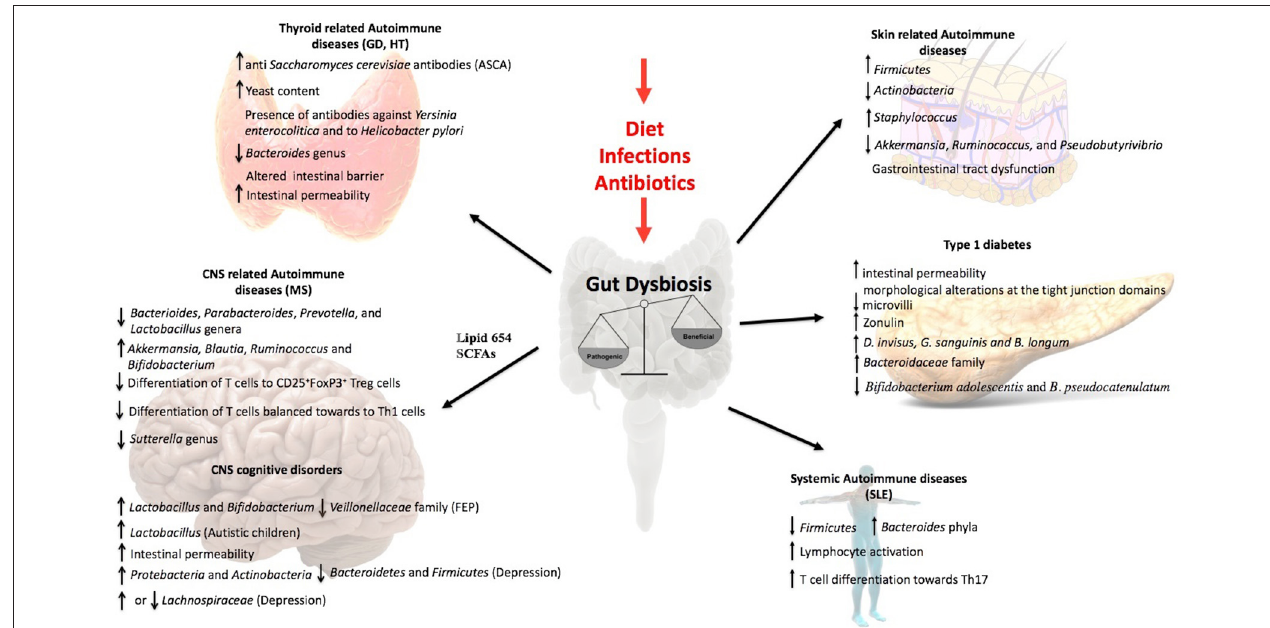
FIGURE 2 | Influence of the gut microbiota in non-intestinal diseases. Gut dysbiosis induced by external factors as diet, infections, or antibiotic overuse lead to an inflammatory response that influence the outcome of several autoimmune diseases as Grave’s disease, Hashimoto’s Thyroiditis, Multiple Sclerosis, SLE, and type1 diabetes. It has also been observed an important role in skin related autoimmune diseases as Psoriasis. Moreover, the evidences in the literature support that gut microbiota can influence CNS disorders like autism, depression, and schizophrenia.